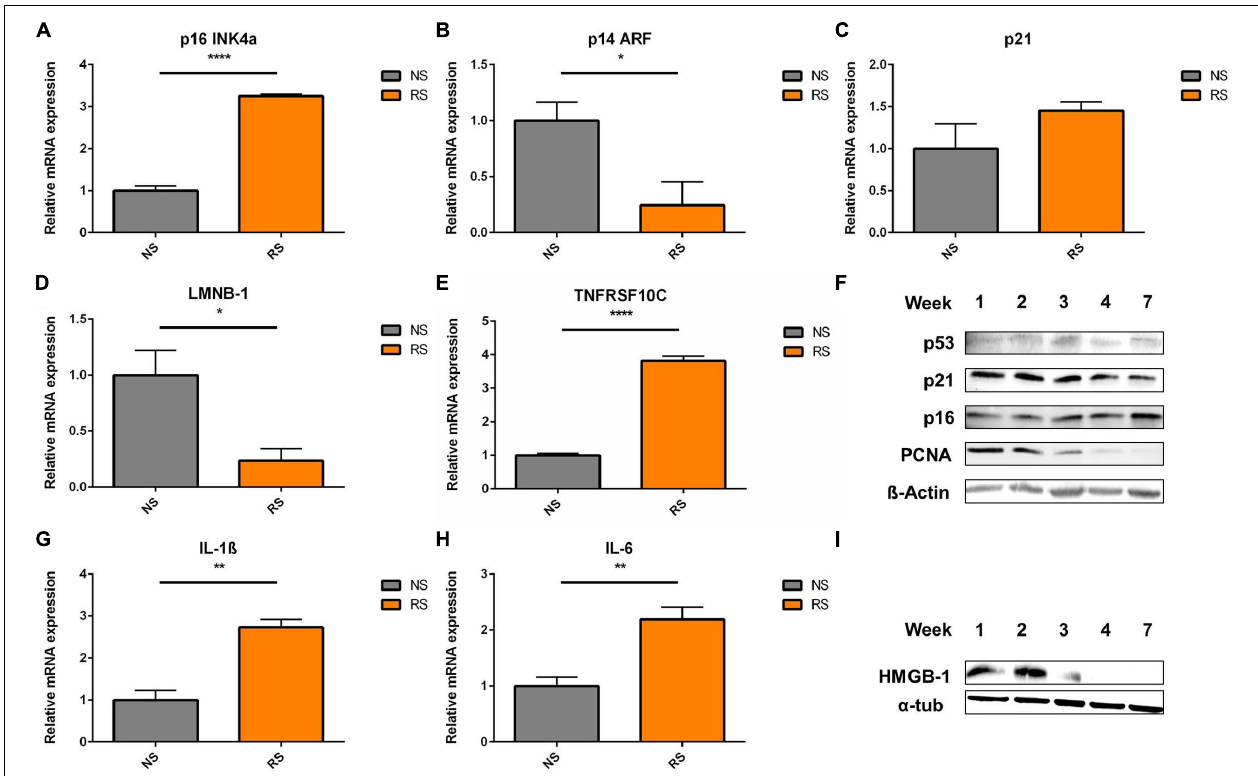
FIGURE 2 | Cell cycle inhibitors and SASP markers in replicative senescence; Expression levels of cell cycle inhibitors (A) p16, (B) p14, (C) p21; (D) nuclear envelope protein LMNB-1- Lamin B1 ( n = 4) and (E) TRAIL receptor 3 and tumor necrosis factor receptor superfamily member 10C (TNFRSF10C) interleukins (G) IL-1 β , (H) IL-6- interleukins ( n = 3), were measured via RT-qPCR, t -test; (F) shows the Western blots a timeline of p53, p21, p16, and PCNA- Proliferating cell nuclear antigen; α -tub- α -tubulin; (I) HMGB-1 (High mobility group box 1) levels in whole cell lysates were analyzed in a passaging timeline until replicative arrest; * p < 0.05, ** p < 0.01, **** p <